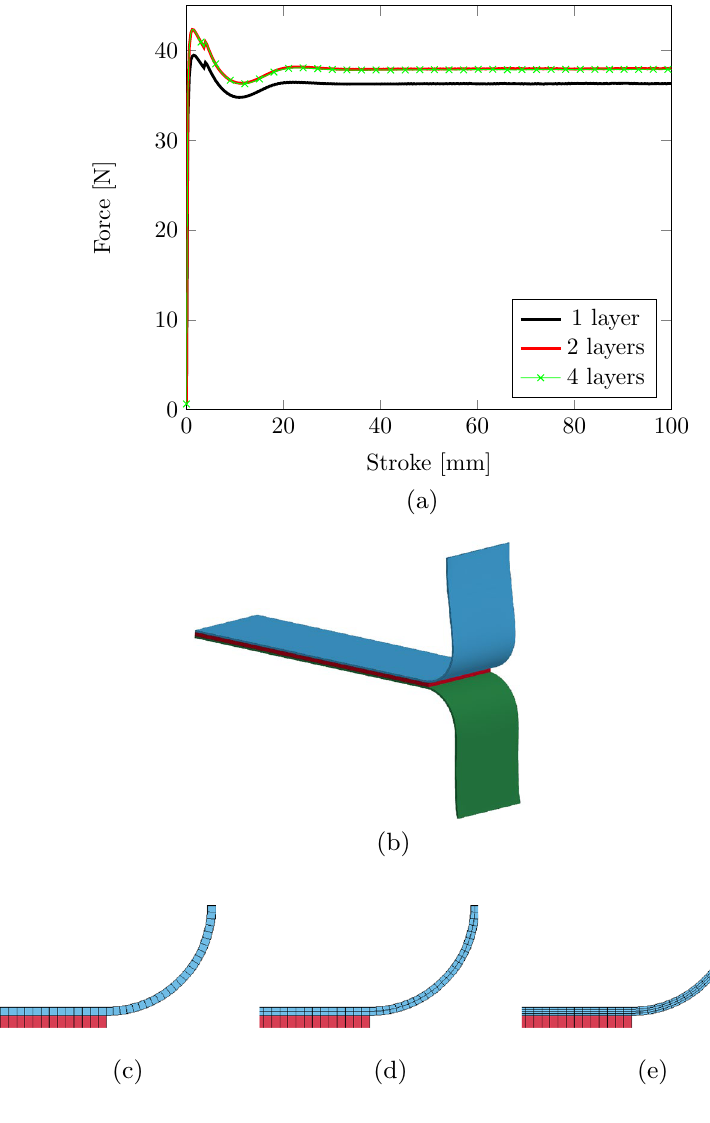
Fig. 12 a Contains the force– displacement responses obtained for the mesh study regarding the skins for the model presented in b . Three mesh densities were studied for the skins, see c – e , where 1, 2 and 4 layers of solid elements has been used, respectively. At this stage the core was modeled using a single layer of solid